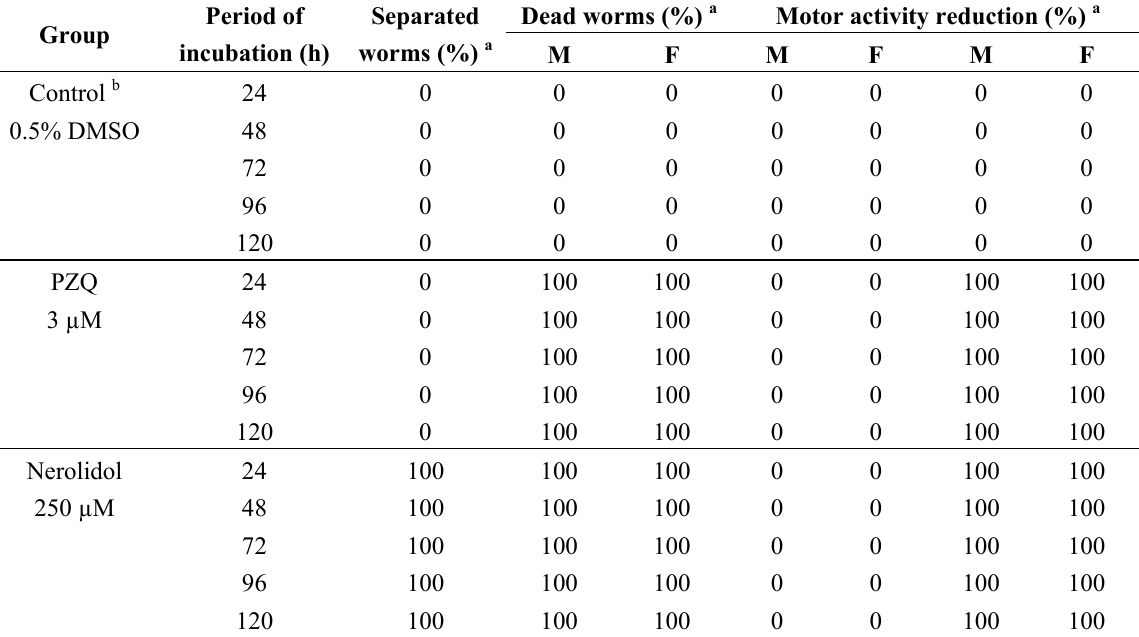
Table 1. In vitro effects of nerolidol against adult Schistosoma mansoni